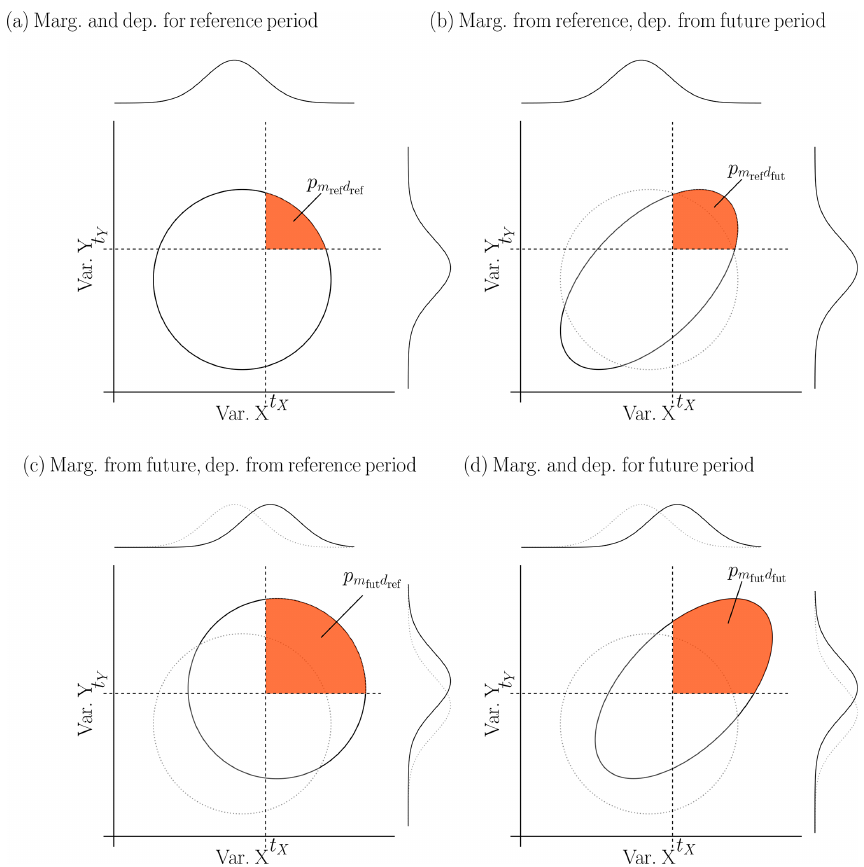
Figure 2. Illustration of the influence of marginal and dependence properties on bivariate exceedance probabilities for an artificial distribution of two contributing variables X and Y during (a) the reference period and (d) a future period with a shift in means and an increase in dependence between the variables. The distribution of the two contributing variables (b) with marginal properties from the reference period and dependence structure from the future period, and (c) with marginal properties from the future period and dependence structure from the reference period. Orange areas show bivariate exceedance probabilities for the thresholds (t X ,t Y ) of the two contributing